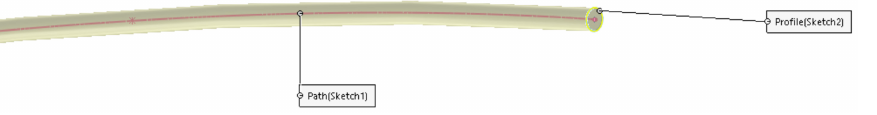
Figure 15. Virtual models of the two undeformed orthodontic wires. As the first step, we placed the bracket and tube elements on the vestibular surfaces of the teeth using CAD methods and techniques in the Assembly module of SolidWorks, as shown in Figure 16. Figure 16. Location of the bracket and tube elements. To obtain models of the deformed orthodontic wires, we defined three points on all the models of brackets and tubes as basic points for defining the Path curves of the wires, as shown in Figure 17.